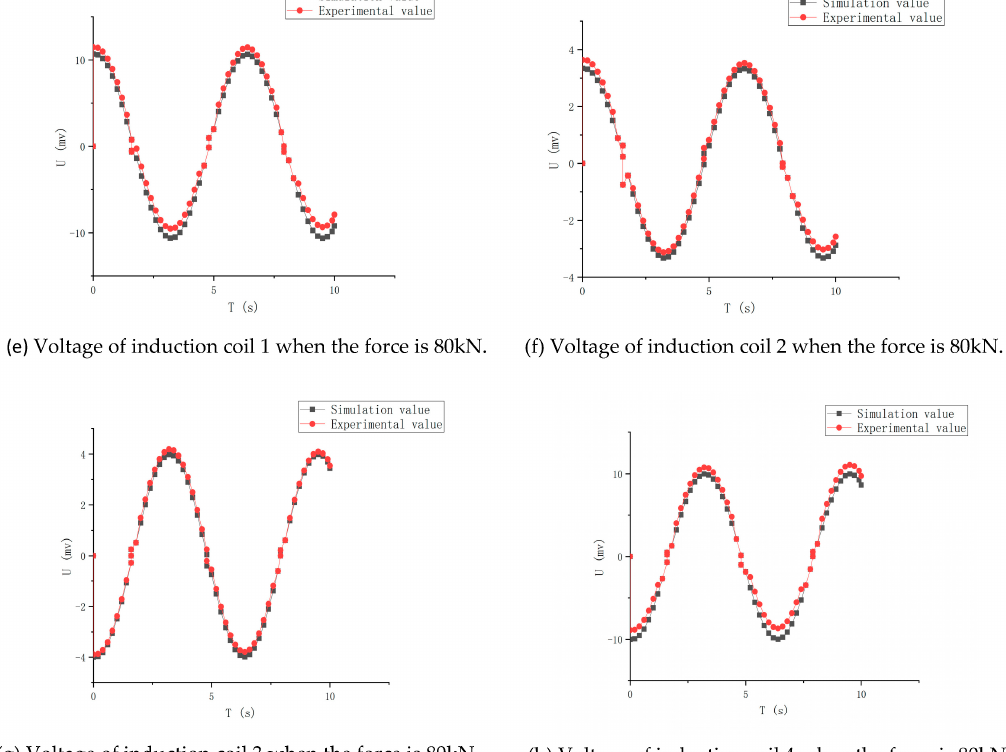
Figure 14. Voltage of each induction coil of piezoelectric magnetic sensor under different external forces. ( a ) Voltage of induction coil 1 when the force is 0 kN, ( b ) Voltage of induction coil 2 when the force is 0 kN, ( c ) Voltage of induction coil 3 when the force is 0 kN, ( d ) Voltage of induction coil 4 when the force is 0 kN, ( e ) Voltage of induction coil 1 when the force is 80 kN, ( f ) Voltage of induction coil 2 when the force is 80 kN, ( g ) Voltage of induction coil 3 when the force is 80 kN, ( h ) Voltage of induction coil 4 when the force is 80